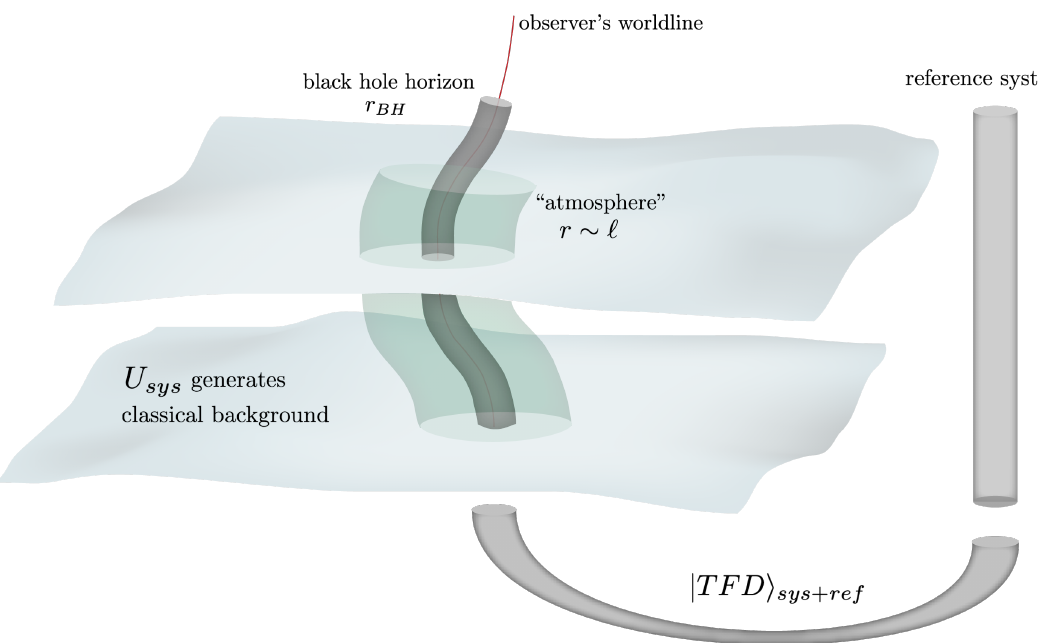
JHEP03(2022)084 Figure 1. An illustration of our setup. The red line represents the worldline of an ideal observer. We replace them by a small black hole of radius r much smaller than the spacetime’s curvature BH features which we thermally entangle with a reference system, assumed to be another AdS black hole for simplicity. The black hole propagates along the original geodesic due to the equivalence principle. The green tube of radius ‘ around the black hole represents its “atmosphere”: the operators our observer can manipulate at any given